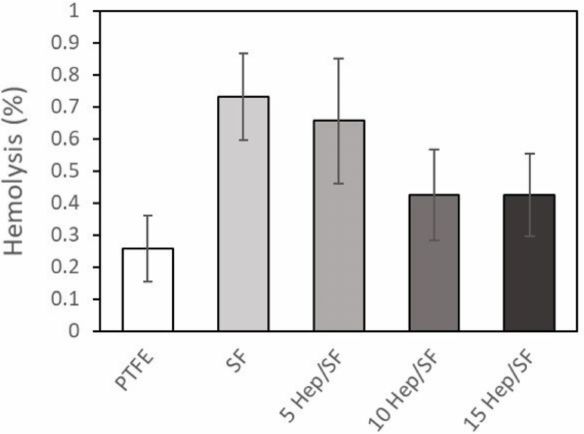
Figure 7. Percentages of hemolysis induced by the samples after 1 h of incubation under diluted blood. Percentages of hemolysis were calculated by comparing to those of normal saline and distilled water as negative and positive controls, respectively.